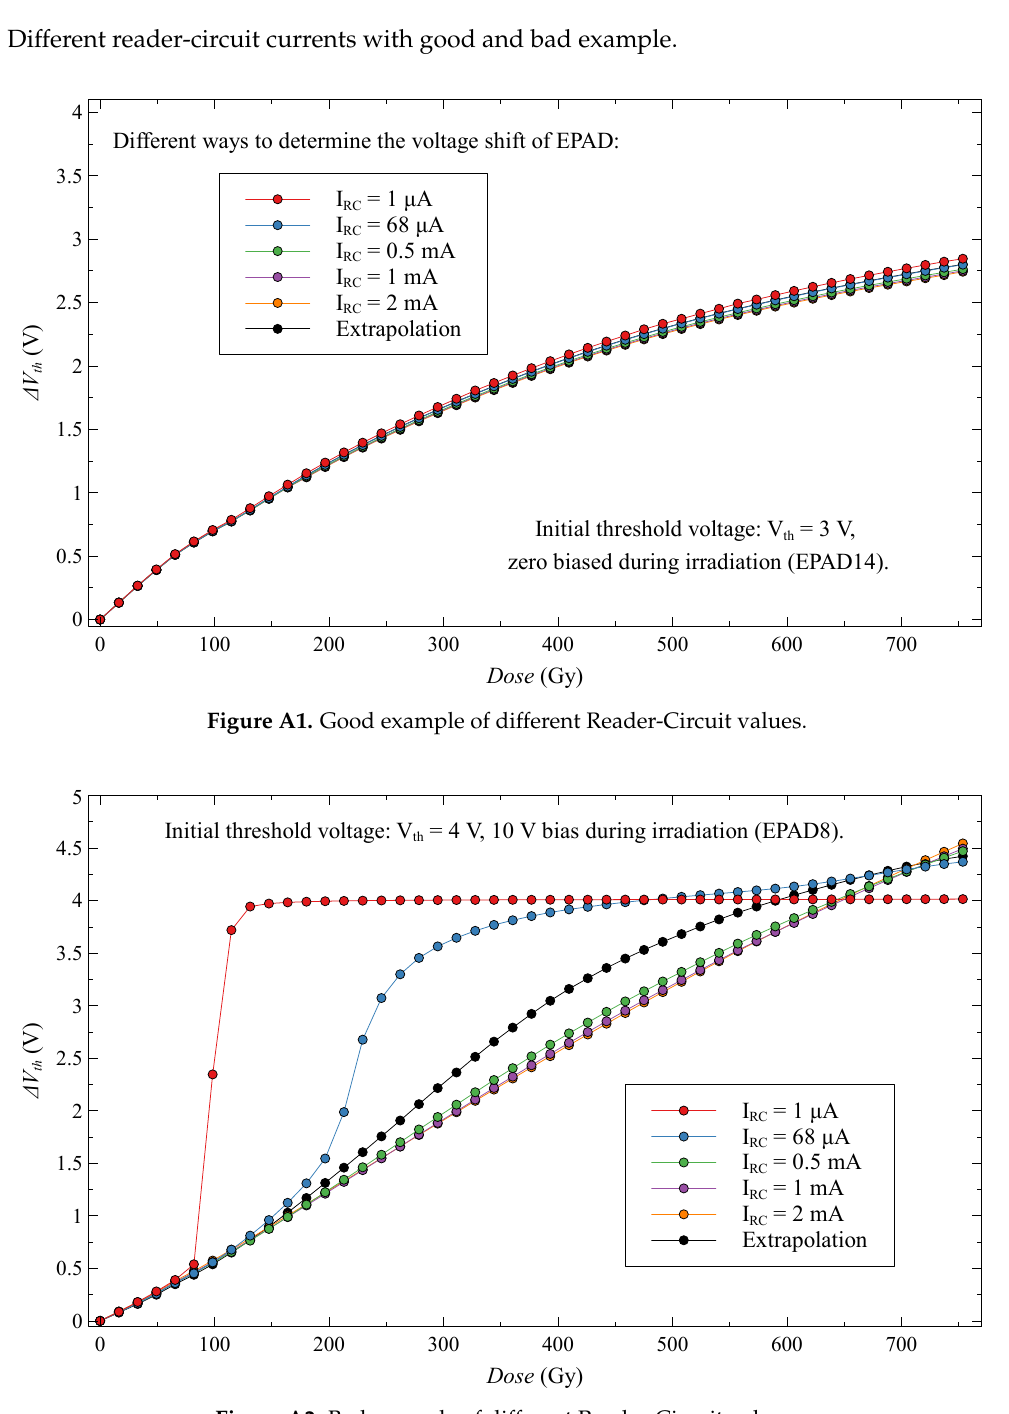
Figure A2. Bad example of different Reader-Circuit